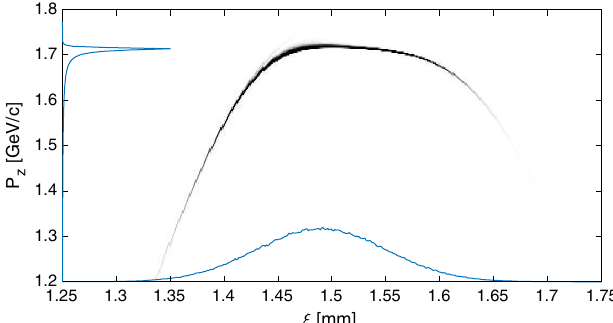
FIG. 4. Longitudinal phase space charge distribution of a 100 pC, 60 μ m long witness beam after 4 m of plasma. The mean momentum is 1 . 67 GeV = c with an RMS energy spread of 87 MeV = c (5.2%) for the full beam.